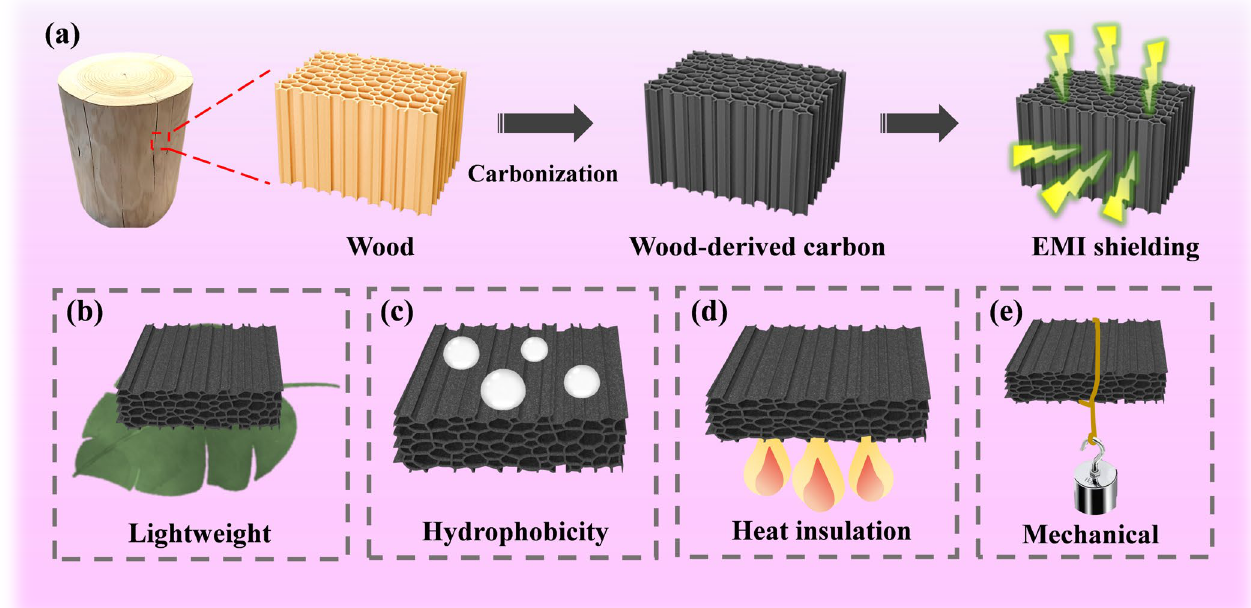
Figure 1. ( a ) Schematic of the preparation of WC for EMI shielding with ( b ) lightweight, ( c ) hydrophobicity, ( d ) heat insulation and ( e ) mechanical properties.